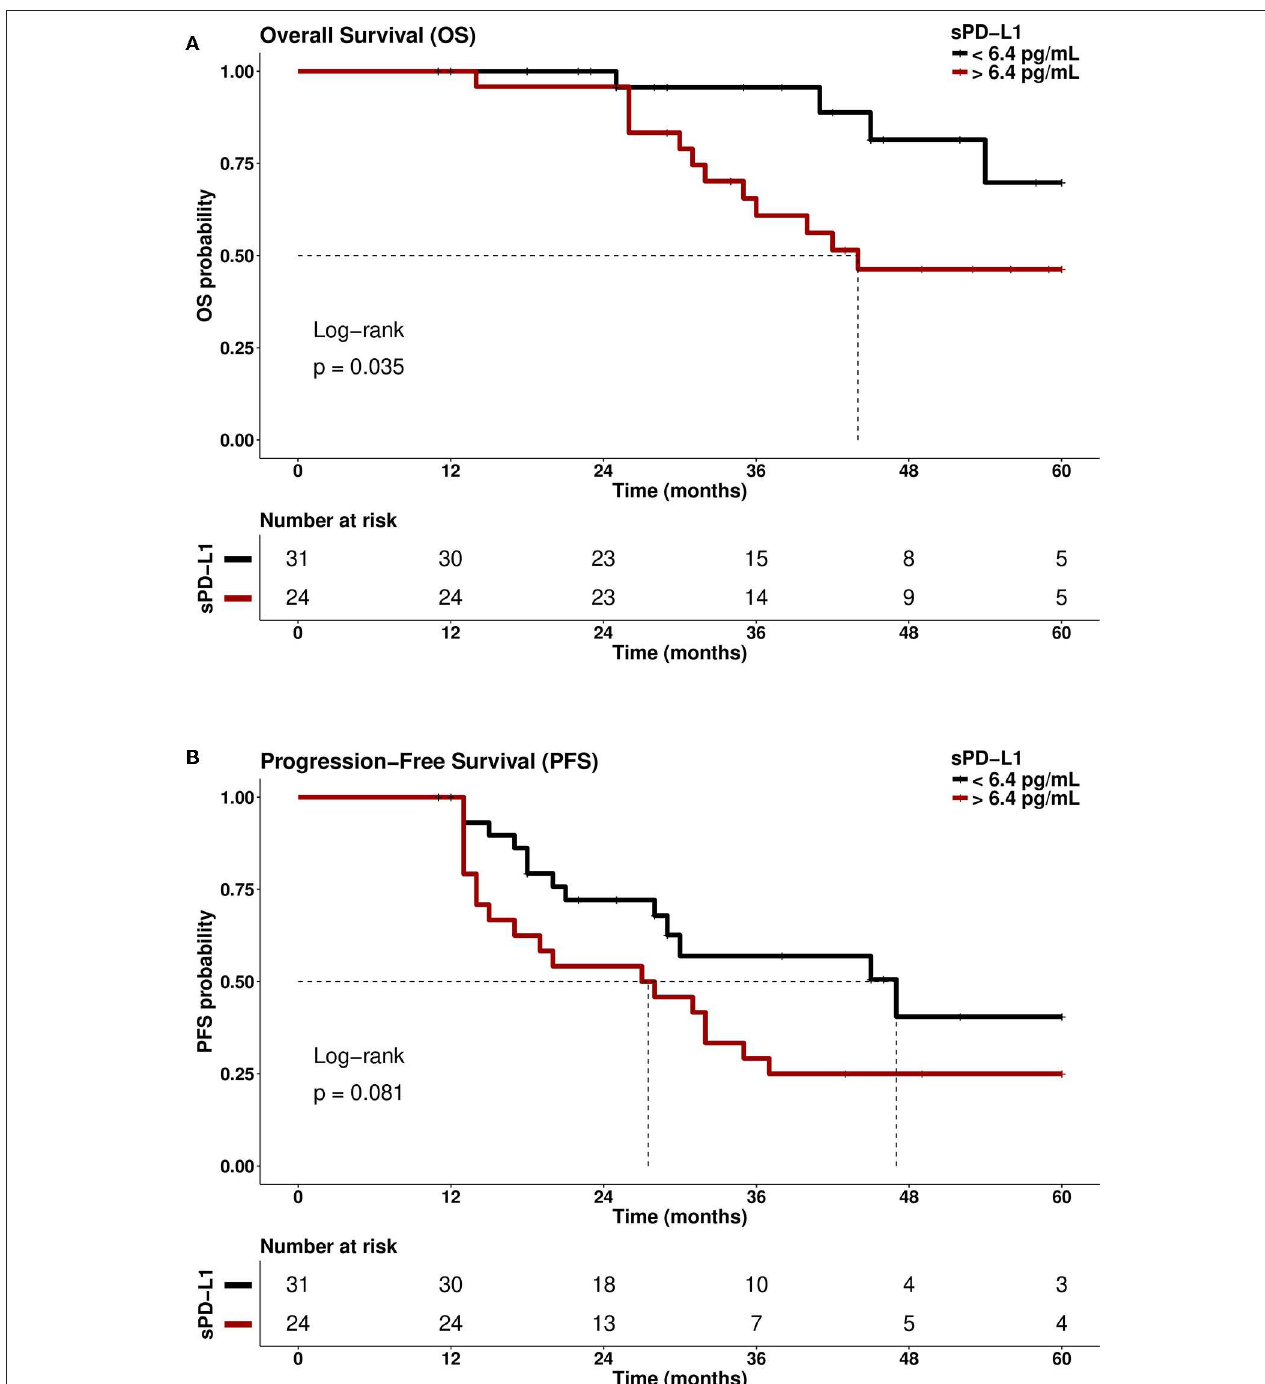
FIGURE 6 | Association of high sPD-L1 levels with reduced overall survival (OS) and progression-free survival (PFS) in platinum-sensitive patients. Platinum-sensitive EOC patients with high sPD-L1 serum levels ( > 6.4 pg/mL) had a reduced (A) overall survival (OS; p = 0.035) and (B) progression-free survival (PFS; p = 0.081) compared with platinum-sensitive patients with low sPD-L1 levels ( < 6.4pg/ml). Time was calculated from blood sampling to event (death/progression) or last follows up. Dotted line indicates the median survival time of EOC patients. interesting to determine if the activation of different anti- antibody Atezolizumab (9) have been successfully used in tumor immune-pathways can help to eliminate CTCs as shown EOC patients. However, little is known about the effect before for of these therapies on the presence of CTCs. It will be